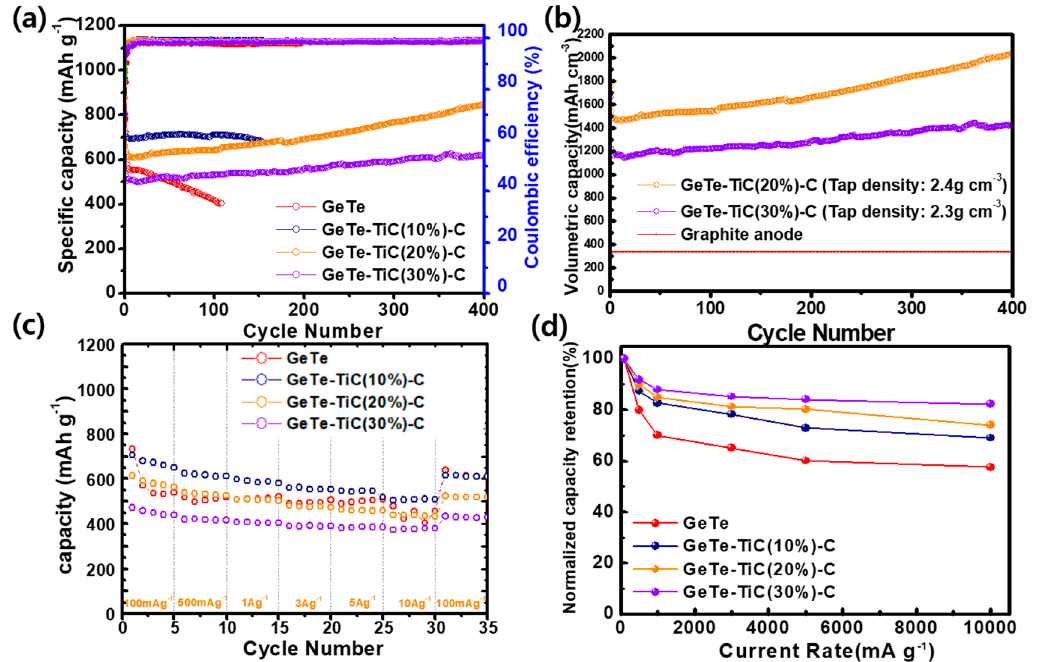
Figure 6. Cycling performance comparison of GeTe and GeTe-TiC-C anodes at 100 mA g − 1 for ( a ) gravimetric capacity and ( b ) volumetric capacity. ( c ) Rate performance of GeTe and GeTe-TiC-C anodes at different current densities and ( d ) their capacity retentions.